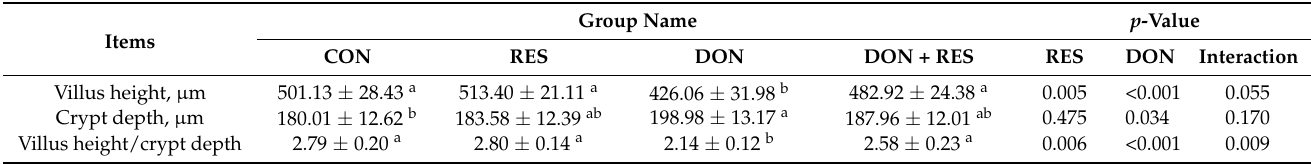
Table 5. The effects of RES on the jejunal morphology of piglets.